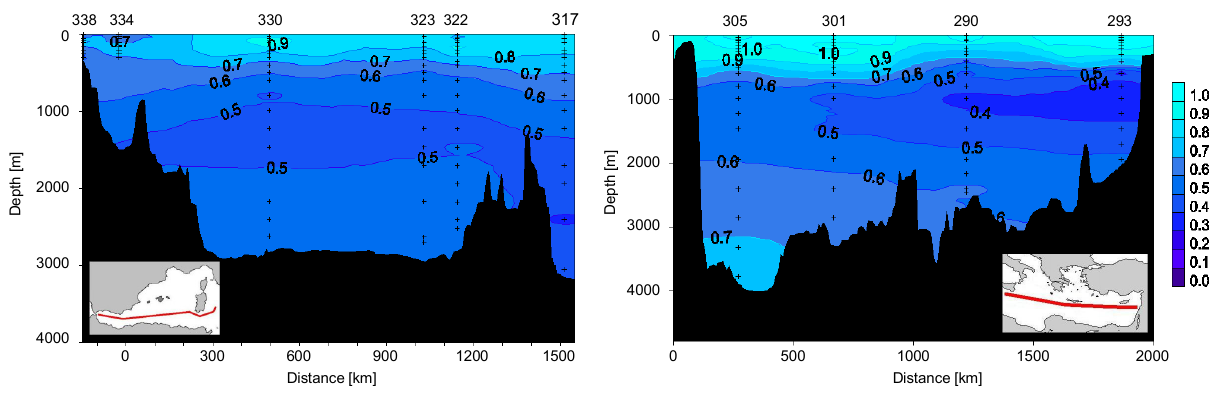
Fig. 5. As Fig. 4, but Meteor 84/3, 2011, left WMed, right